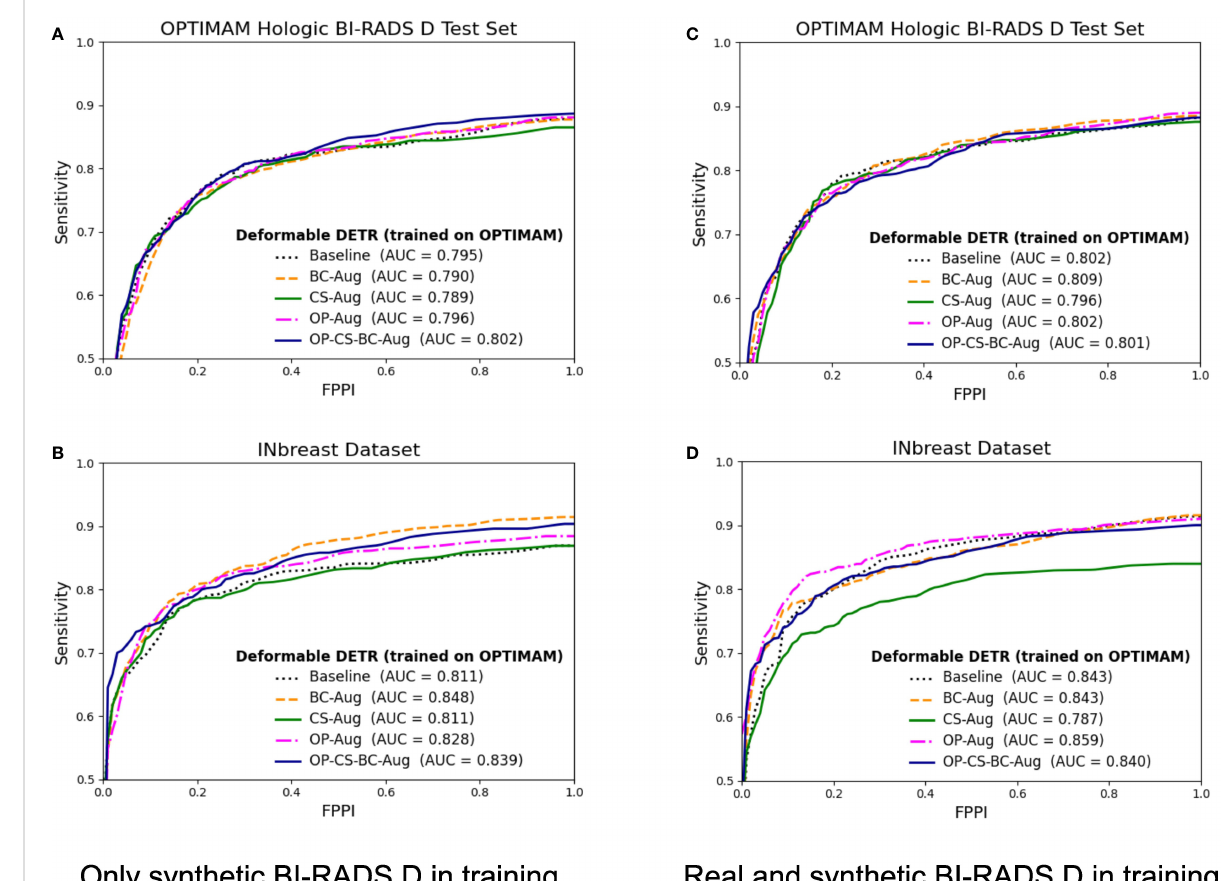
FIGURE 6 FROC curves for the mass detection models trained using OPTIMAM Hologic database. The baseline model did not include synthetic data augmentation in the training. The BC-Aug , CS-Aug , OP-Aug and the OP-CS-BC-Aug models used synthetic images from the corresponding CycleGAN models. (A, C) The OPTIMAM Hologic test set contained 120 BI-RADS D mammograms with annotated masses, (B, D) The INbreast test set containing 107 mammograms with annotated masses from different breast densities, used for external validation. (C, D) The models were trained with 41 additional real BI-RADS D mammograms. (For interpretation of the references to color in this fi gure legend, the reader is referred to the web version of this